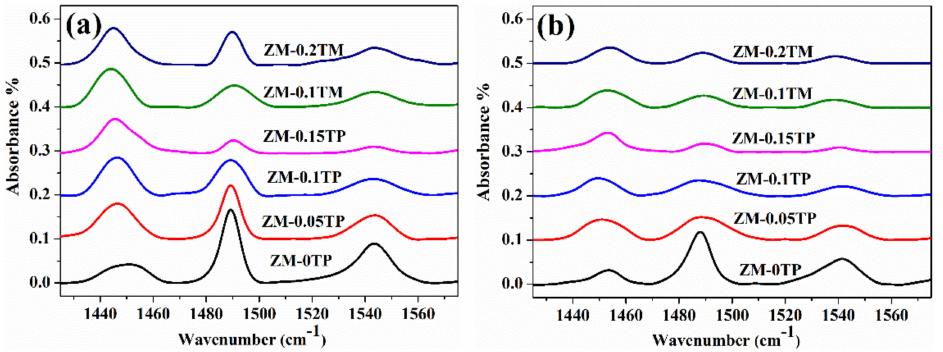
Figure 6. Pyridine-adsorbed FT-IR spectra of the zeolite powders at ( a ) 150 ◦ C and ( b ) 350 ◦ C.